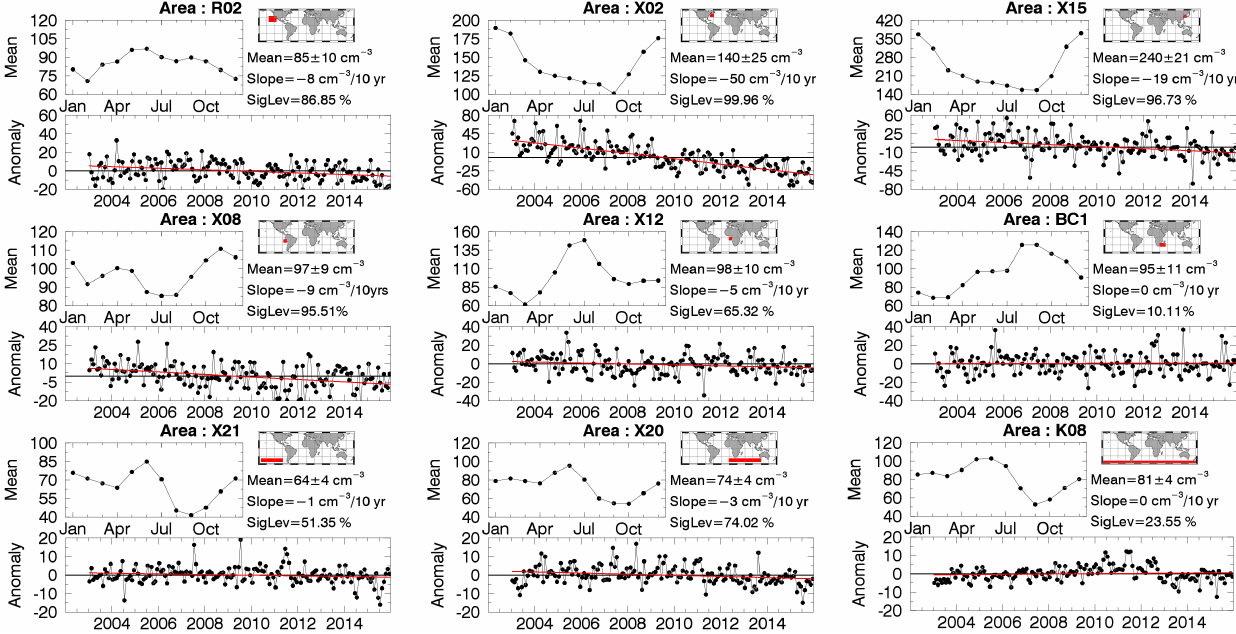
Figure 11. Mean CDNC annual cycle, monthly CDNC anomalies, and statistics for selected areas as shown in Fig. 9 and summarized in Table 3. The red curve in the anomaly plots is the regression